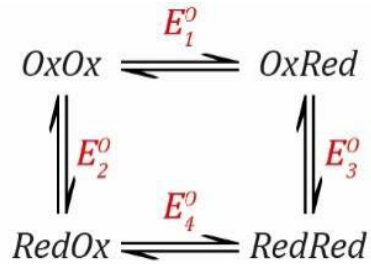
or to RedOx with a redox potential 1